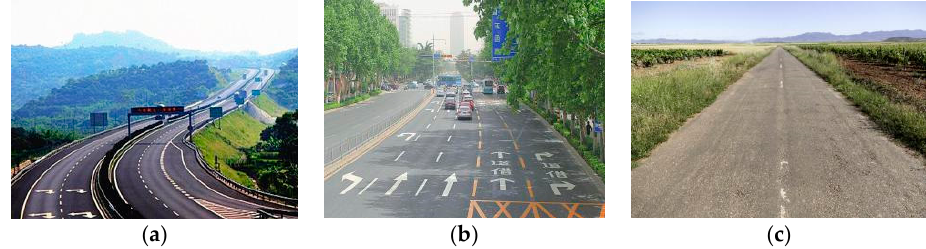
Figure 4. Road environment for three types of traffic: (a) Highways; (b) Urban roads; (c) Rural roads.